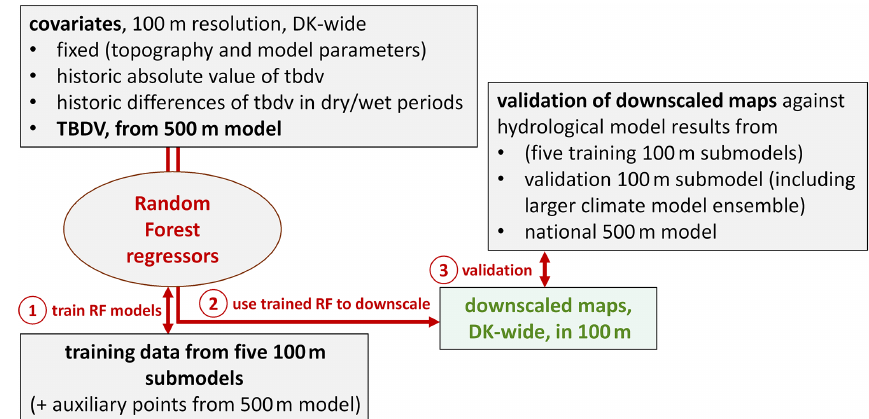
Figure 3. Diagram of the downscaling